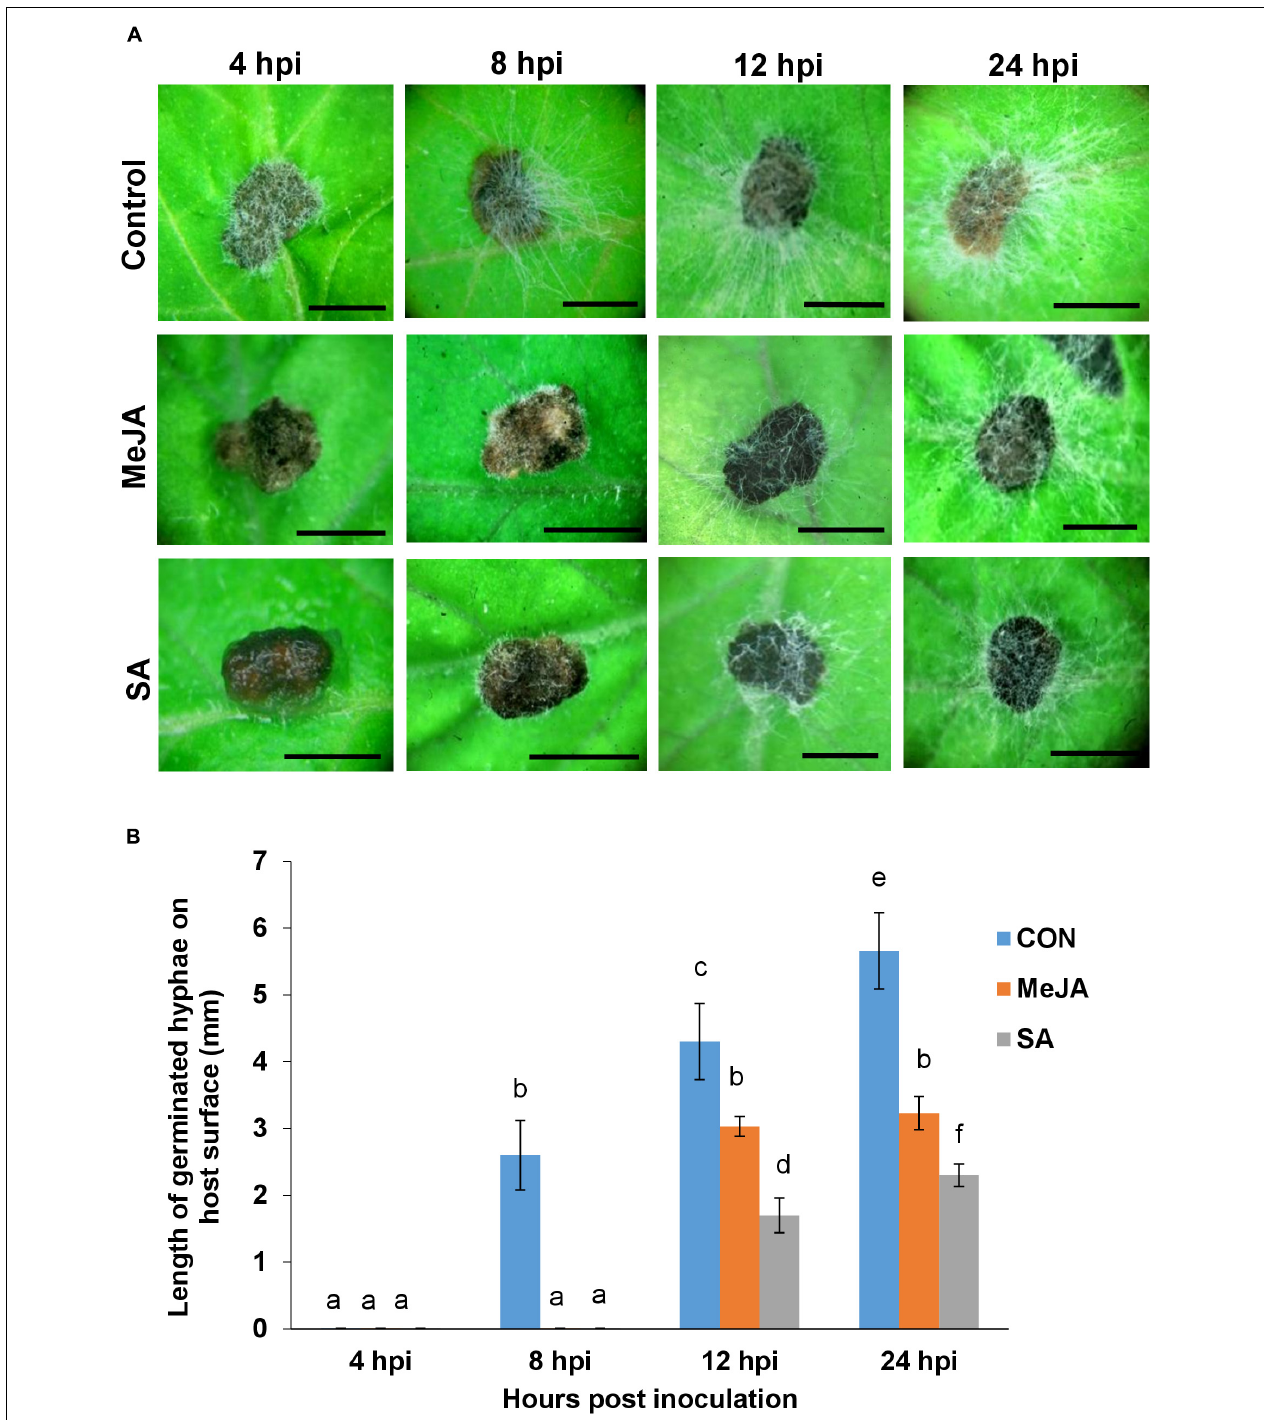
FIGURE 2 | Behavior of germinating R. solani sclerotia on tomato leaves primed with MeJA or SA compared with the control observed over a 24 h time course. (A) Top row: Sclerotia starting to germinate vigorously within 4 h after placement on the control leaves. Profuse infection hyphae spreading in all directions almost covering the leaf surface by 12 and 24 hpi. Middle row: Sclerotia showing delayed germination on the MeJA-primed leaves with infection hyphae of measurable length being visible only from 12 hpi. Bottom row: Sclerotia showing the most delayed germination and the lowest amount of infection hyphae on the SA-primed leaves. (B) Graph showing the comparison of length of infection hyphae from germinating sclerotia on control, MeJA-primed, and SA-primed leaves. Bars represent mean ± SEM of three independent experiments with three replicates. Different letters indicate significant differences among treatments at p < 0.05 according to Duncan’s multiple range test. Bar = 1